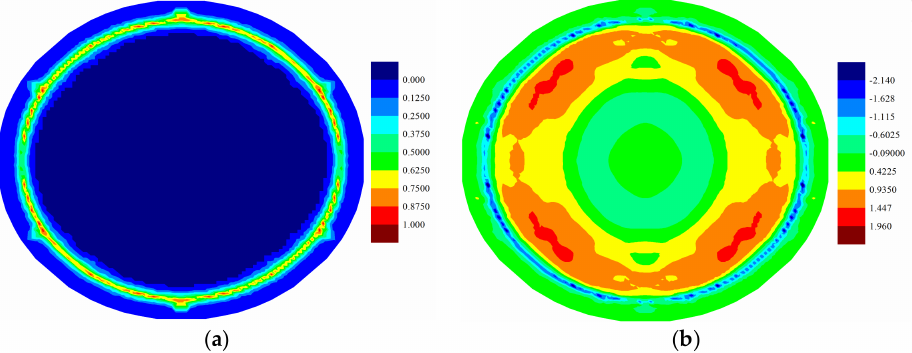
Figure 8. ( a ) Matrix damage and ( b ) temperature change distribution (K) of top ply at 0.1538 × 10 − 3 s.